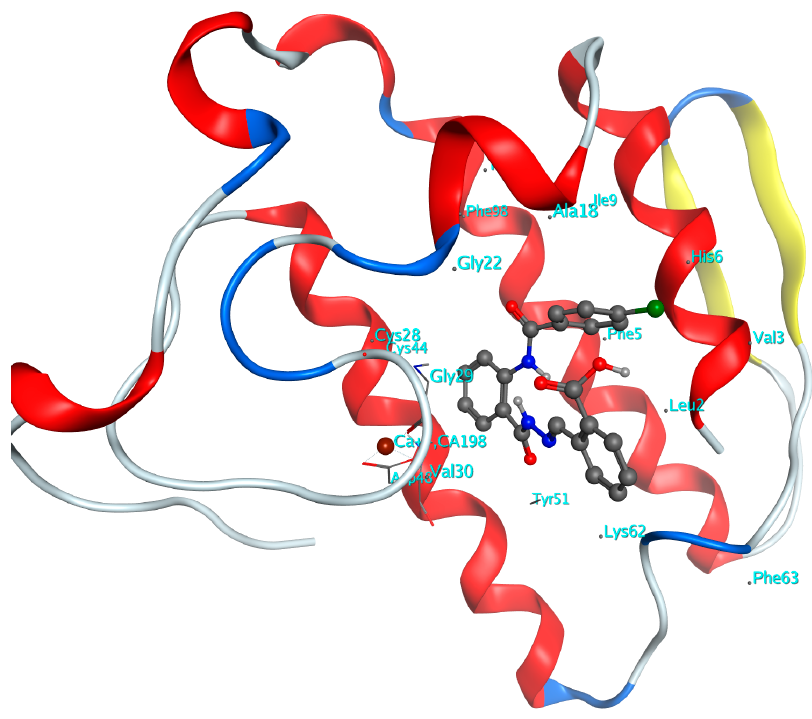
Figure 3. Docking pose for compound 6l as a representative, in the active site of GIIAsPLA 2